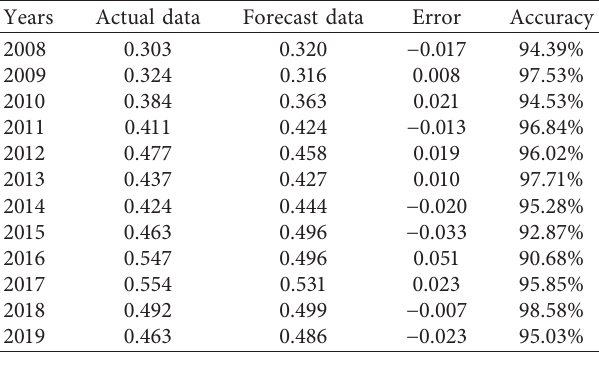
Table 5: The prediction and fitting data of the Holt-Winters model.